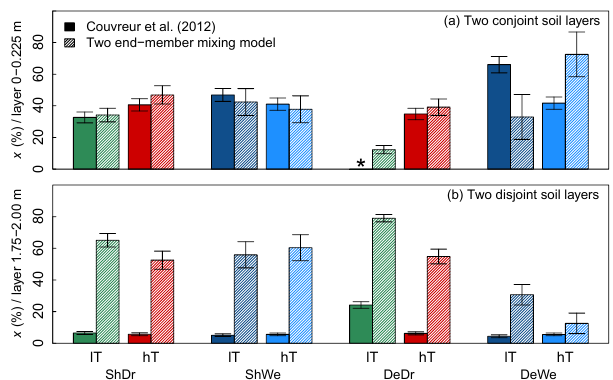
Figure 6. Comparison between relative contributions to transpira- tion ( x , in %) simulated by the analytical RWU model of Couvreur et al. (2012) and the two-end-member mixing model in the case of two defined soil layers. Panel (a) displays x from the topmost soil layer (0–0.225m) in the case of two conjoint soil layers (0–0.225 and 0.225–2.00m), whereas (b) displays x from the lowest soil layer (1.75–2.00m) in the case of two disjoint soil layers (0–0.225 and 0.225–2.00m); i.e., information on soil water isotopic compo- sition is lacking between 0.225 and 1.75m. “Sh” (“De”) stands for the virtual experiments where the soil has a shallow (deep) ground- water table, while “Dr” and “We” stand for when the soil is dry or wet at the surface. Suffixes “lT” and “hT” refer to “low” and “high” transpiration rate simulations. “ ∗ ” refers to when hydraulic redistri- bution is simulated by the analytical model, leading to a negative x . Error bars are either 1 standard deviation (for the RWU analytical model) or 1 standard error (for the TM